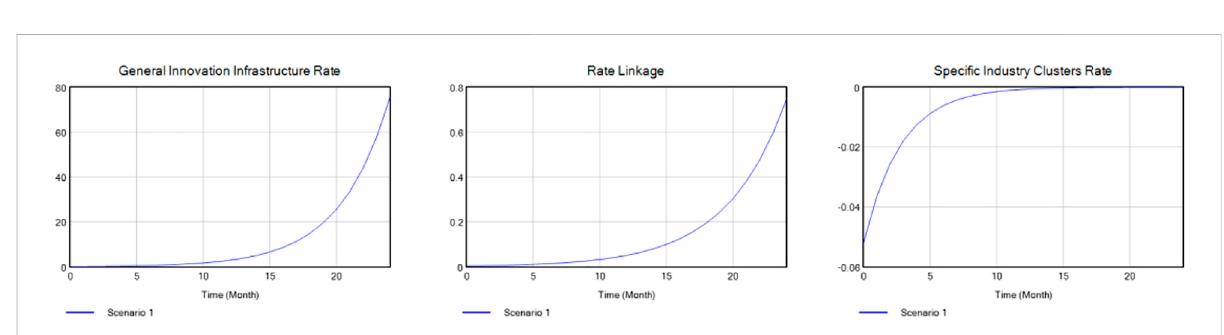
FIGURE 10 Intermediation variable intervention scenario simulation results source: Data Processing Results,